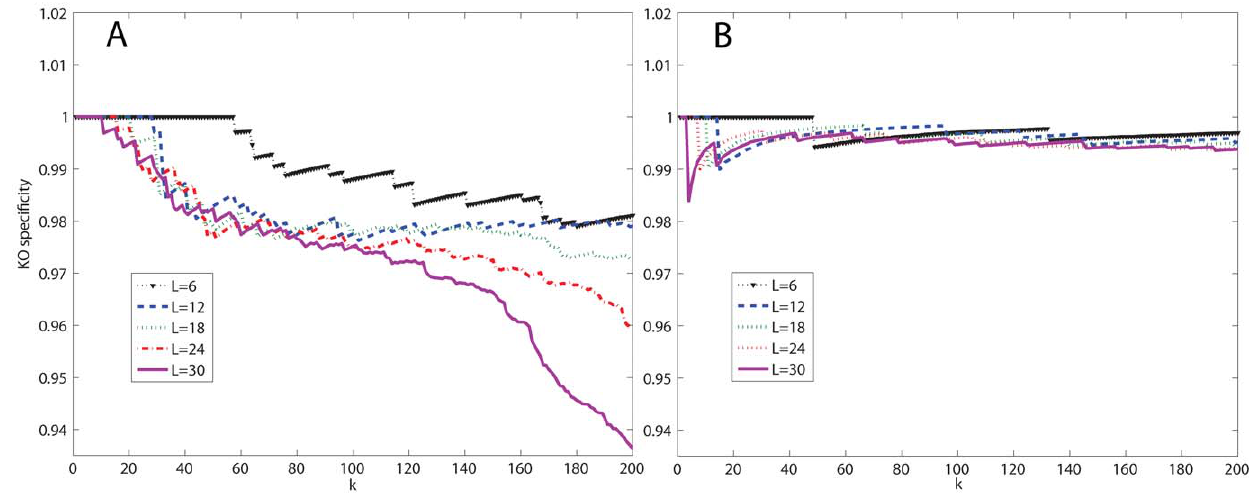
Figure 4. Functional specificity for microbial network alignment. The cumulative specificity of the top 200 aligned pathways obtained from (A) the pairwise alignment between E. coli and C. crescentus networks; and (B) the pairwise alignment between E. coli and S. typhimurium networks.